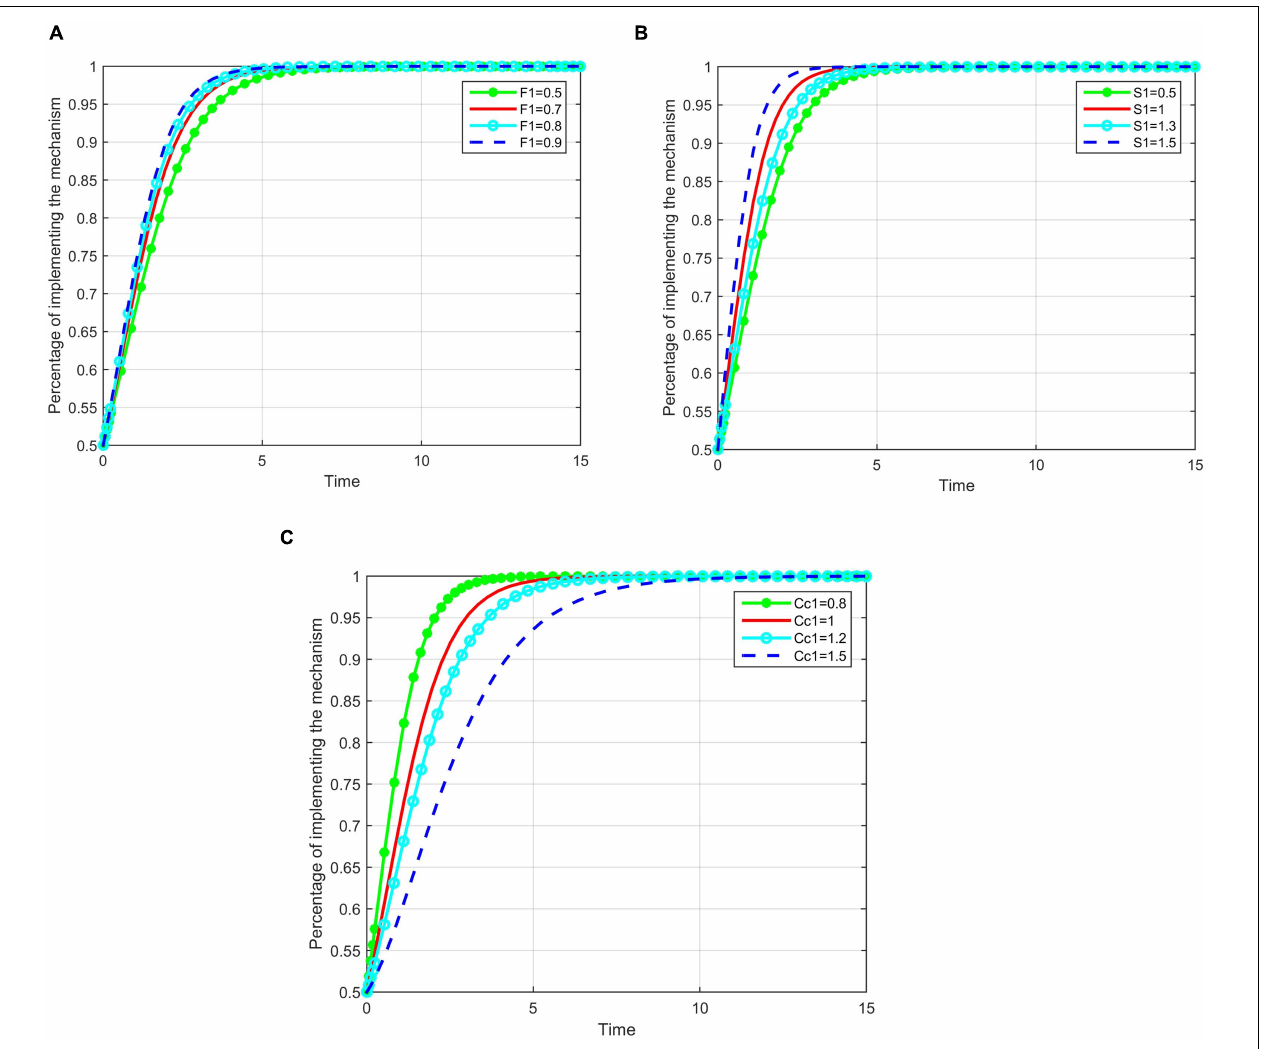
FIGURE 3 | The impact of fine, subsidy and cost on implementing the first mechanism. (A) The impact of fine on implementing the first mechanism. (B) The impact of subsidy on implementing the first mechanism. (C) The impact of cost on implementing the first mechanism. TABLE 6 | The parameter